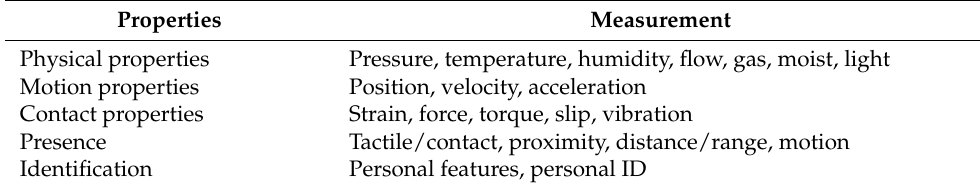
Table 6. Sensors in smart environments (adapted from